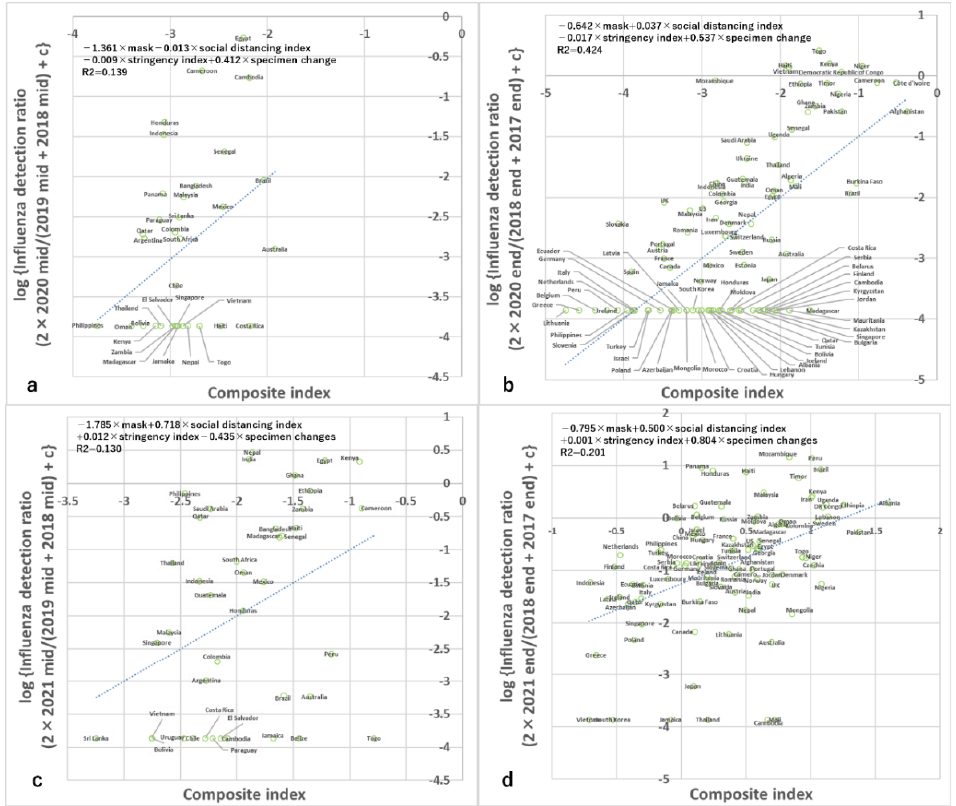
Figure 3. Association between the composite index of infection control measures and influenza reduction in all four seasons. Association between influenza detection rate and the composite index of mask use, social distancing index, stringency index, and number of weeks with data in ( a ) 2020 mid-season, ( b ) 2020 end-season, ( c ) 2021 mid-season, and ( d ) 2021 end-season. c in the y-axis is 0.0137. Note the many data points of the lowest value of the y-axis in panel b correspond to no detection of influenza during the period according to the conversion equation.